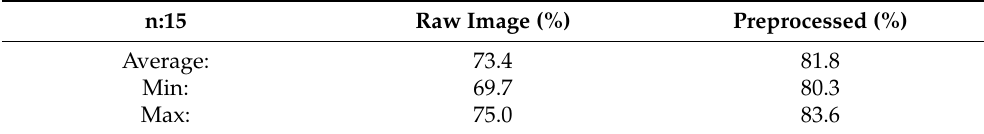
Table 5. Accuracies for the comparison.